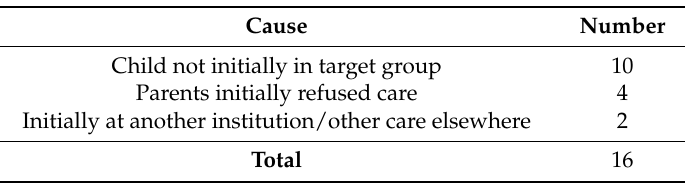
Table 7. Causes of late